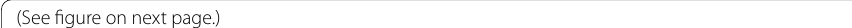
sets(See figure on next Fig. 12 Energy released values and Ib-value is plotted against time of the loading process up to failure in all three cases i.e. ( a ) Intact rock block ( b ) block with horizontal joint set and ( c ) block with vertical joint